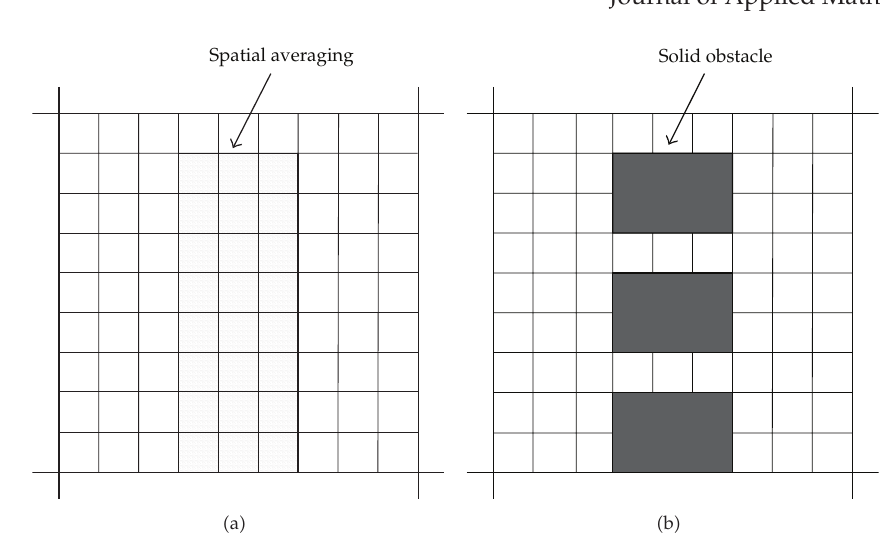
Figure 1: How to handle the porous fence. (cid:7) a (cid:8) Reproduced as a drag law. (cid:7) b (cid:8) Directly reproduced configu-